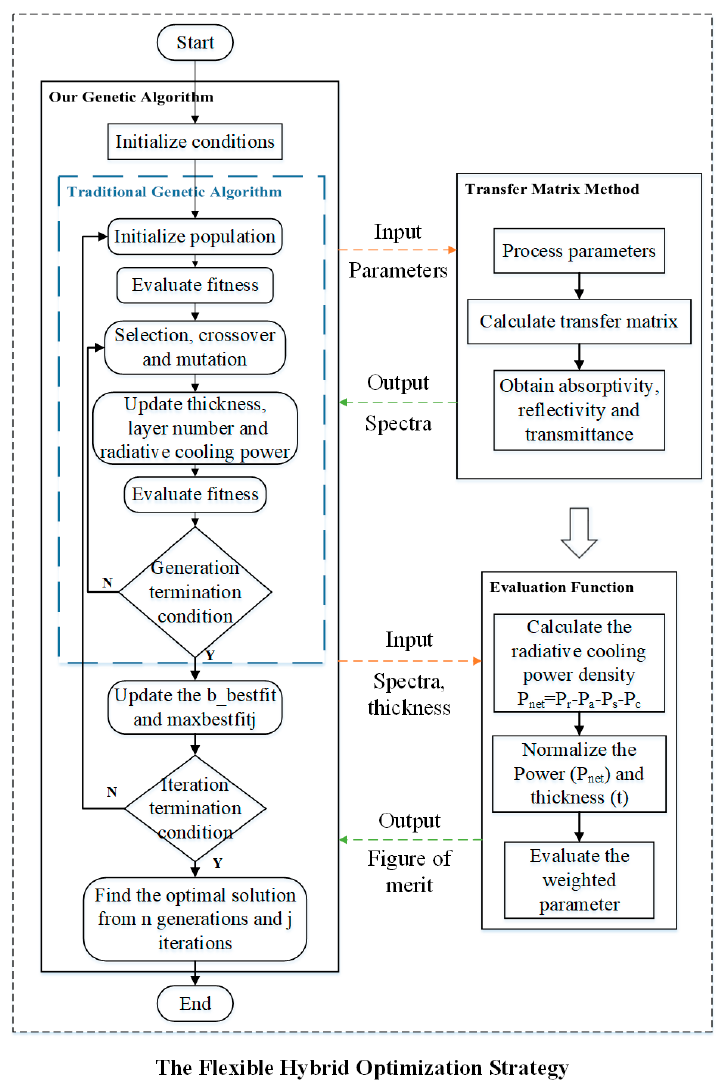
Figure 1. Flow chart of the flexible hybrid optimization strategy (FHOS) for the optimization evaluation. The three parts, the genetic algorithm (GA) (left side), the TM method (upper right) and the evaluation (EV) function (lower right), exchange the information to evaluate the solution candidates.